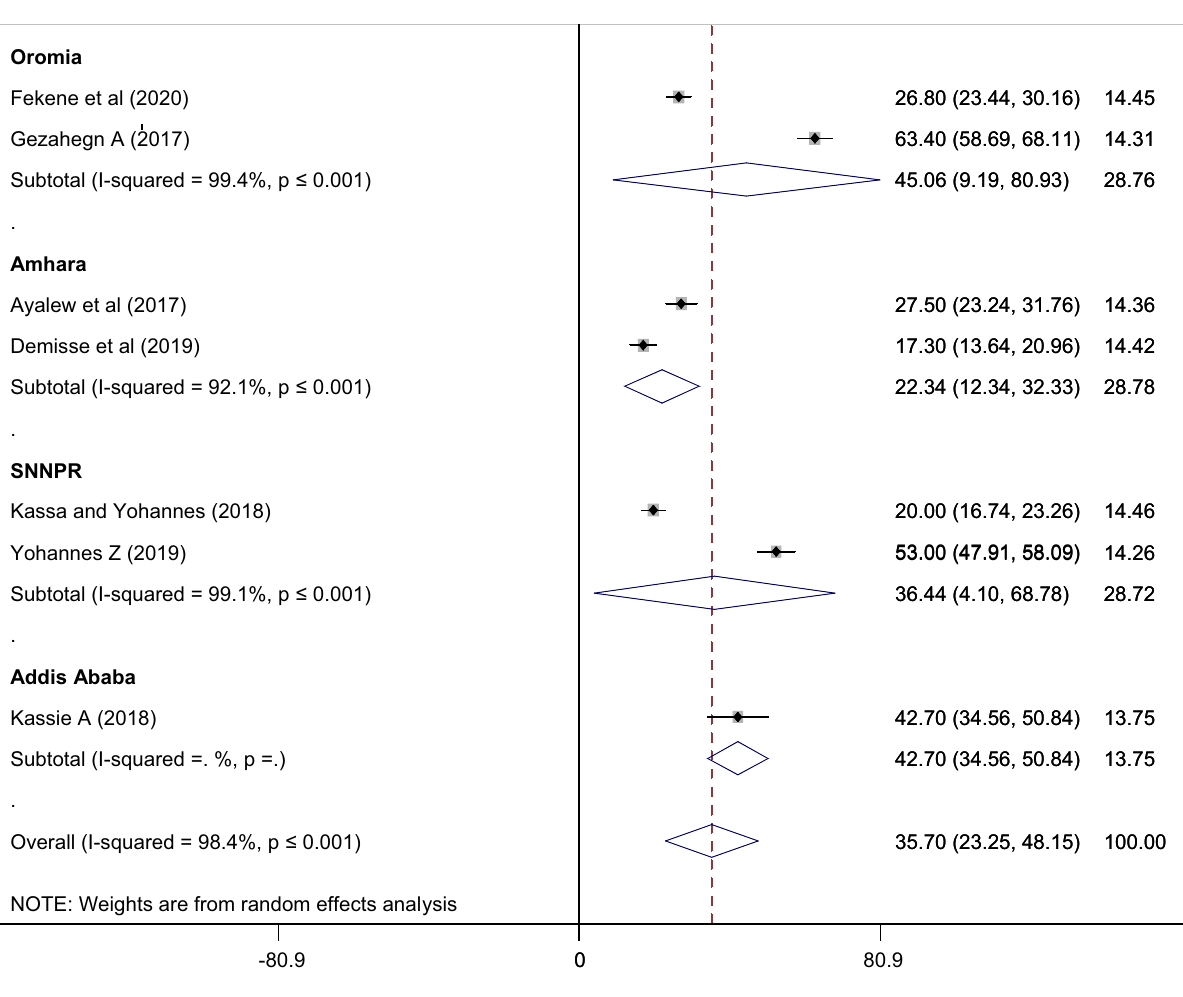
Figure 3. Preconception care knowledgeable women by region in